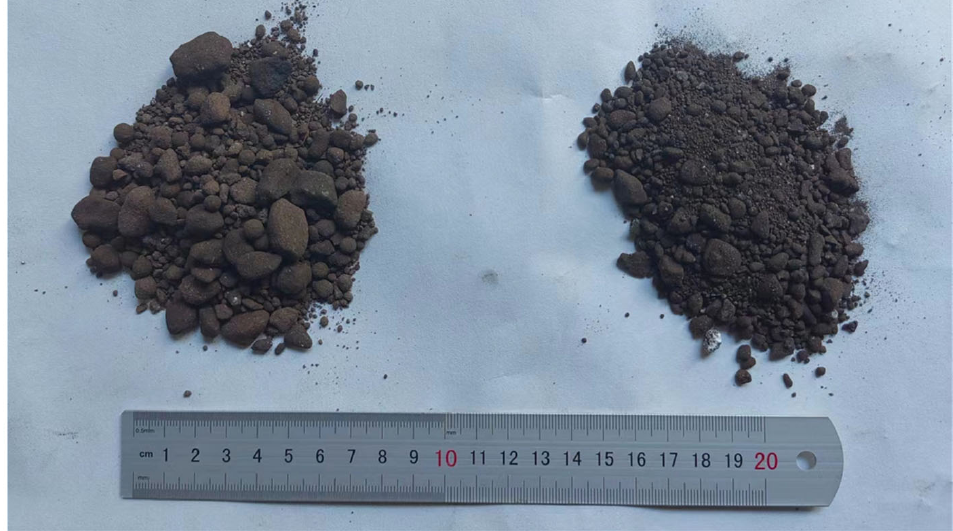
Figure 4. The morphology of quasi-particles of conventional granulation ( right ) and pre-pelletizing granulation ( left ) at 28% MCI proportion.